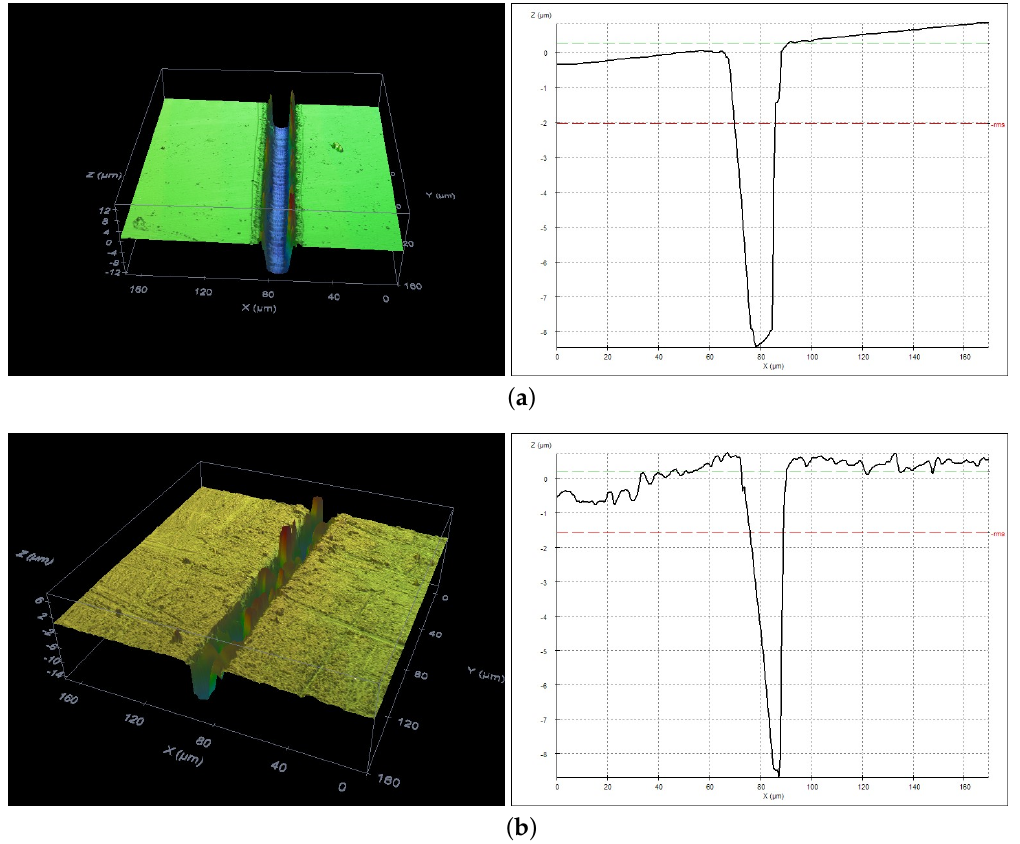
Figure 12. Profiles of the ablated grooves of soda–lime glass in 20% KOH aqueous solution ( a ) and in air ( b